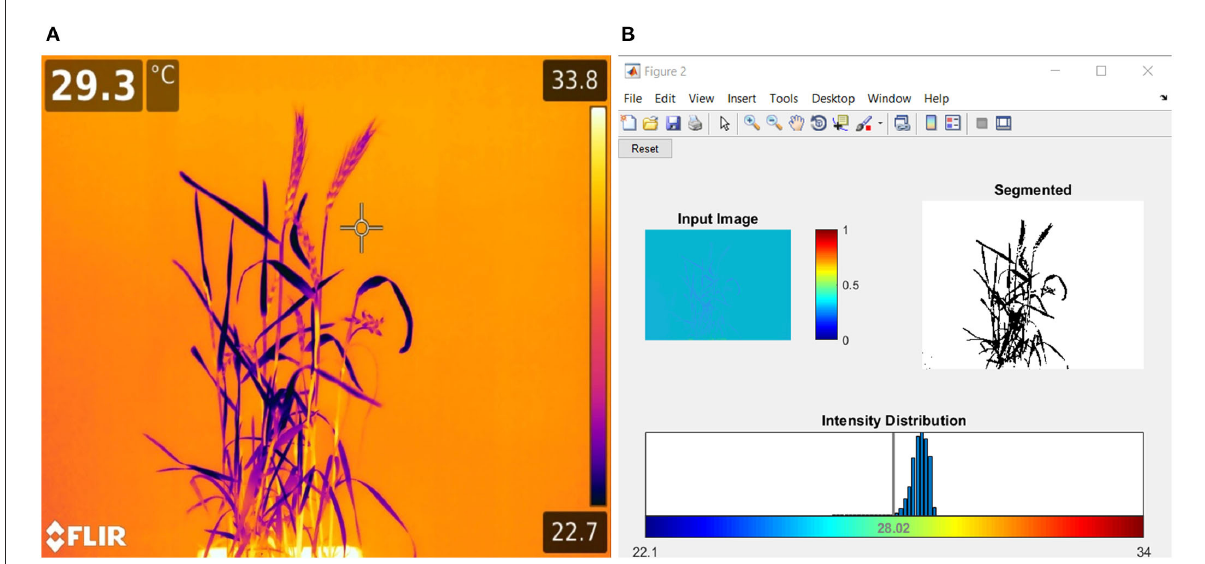
FIGURE1 (A) Sample thermal image and (B) image analysis graphic user interphase (GUI) used for crop water stress index (CWSI), canopy temperature (T c ), and canopy temperature depression (CTD) calculations of plants through a customized code written in MATLAB (Fuentes et al., 2012).